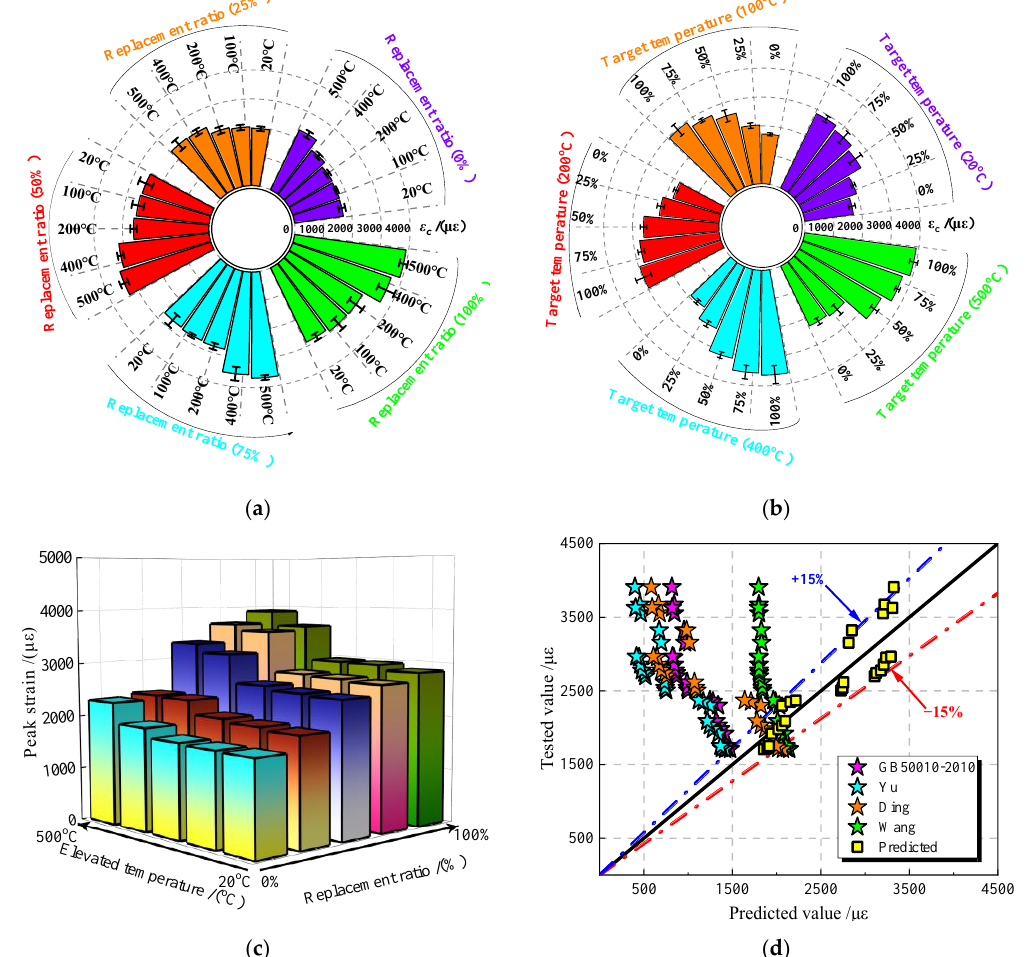
Figure 12. Peak strain of JNC. ( a ) Effect of elevated temperature on ε c . ( b ) Effect of replacement ratio on ε c . ( c ) Variation of ε c under the effect of replacement ratios and elevated temperatures. ( d ) Comparison of the tested values and the predicted values [34,35,37,38].